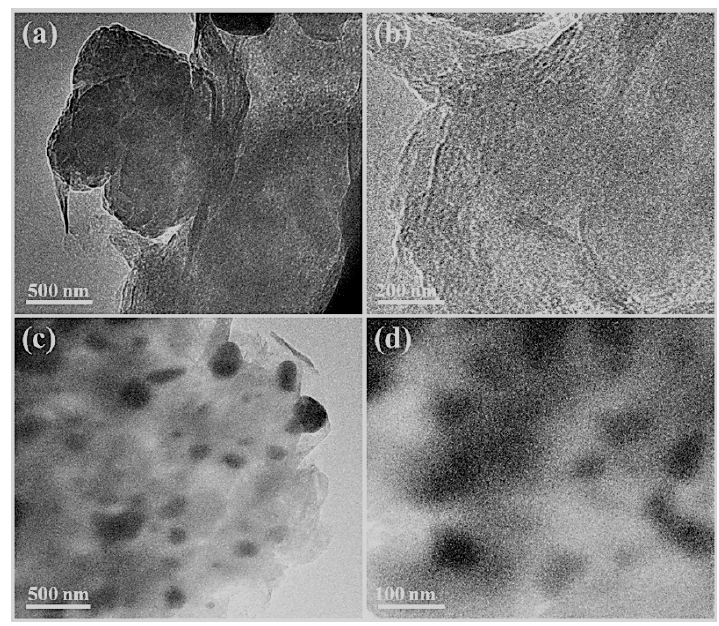
Figure 3. TEM images of BP-PS-PPy ( a and b ) and BP-PS-PPy /Ag ( c and d ).